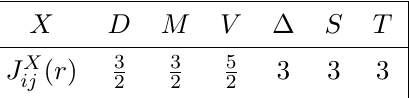
( r ) for N = f D , M , V , (cid:1), S , T g derived ij ( r ) (cid:25) 1 in the limit of vanishing neutrino masses, m i (cid:25) 0. These appear in ij and V V T in this work. , V LR , V RR , V V S (cid:11)(cid:12) (cid:11)(cid:12) (cid:11)(cid:12) (cid:11)(cid:12) (cid:11)(cid:12)